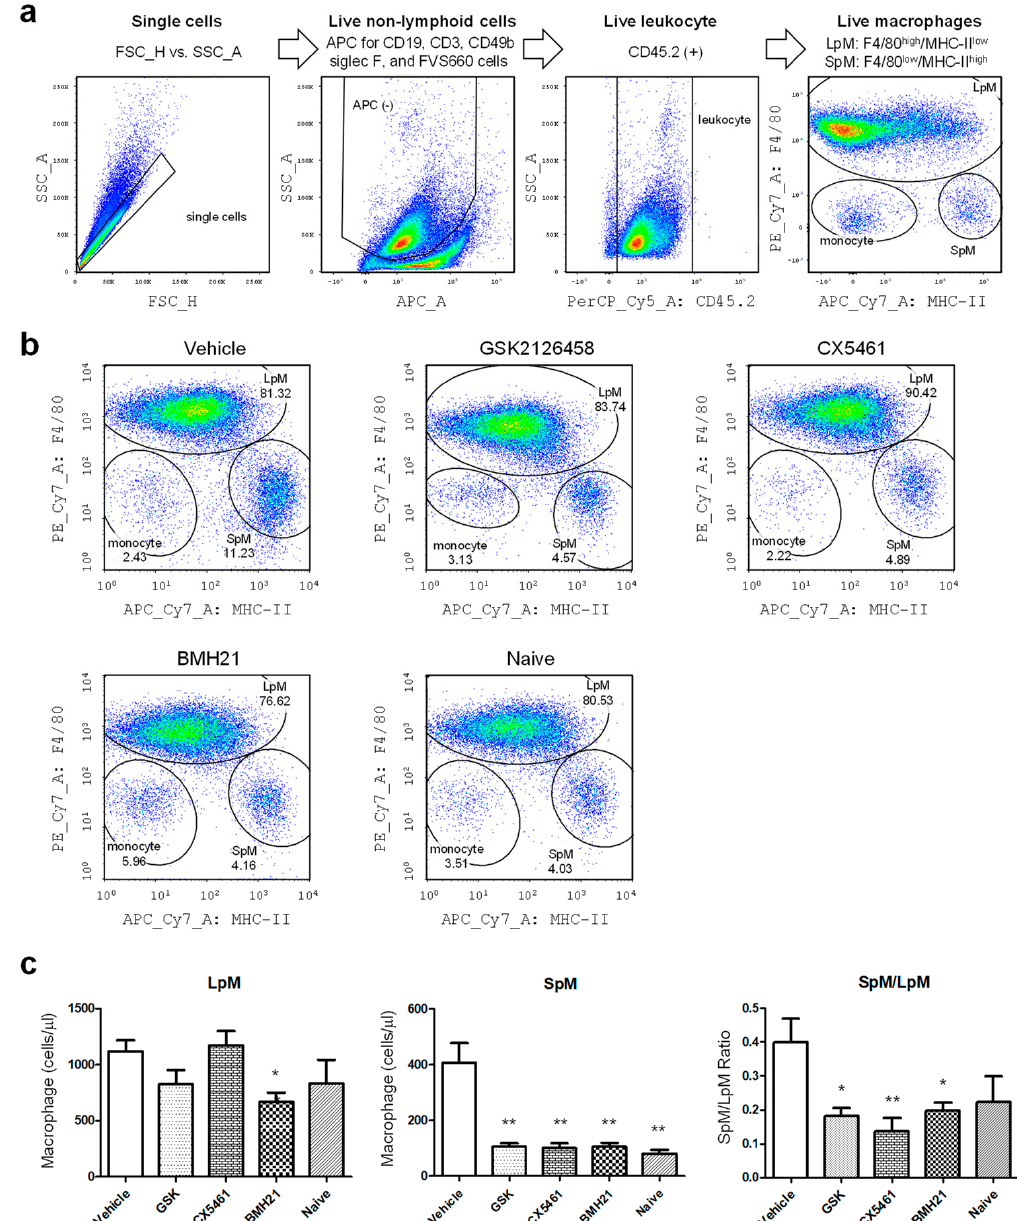
Figure 3. Regulation of macrophage populations in the peritoneal cavity of mice with induced en- dometriosis by anti-ribosome biogenesis agents. ( a ) Multicolor flow cytometry was applied to gate